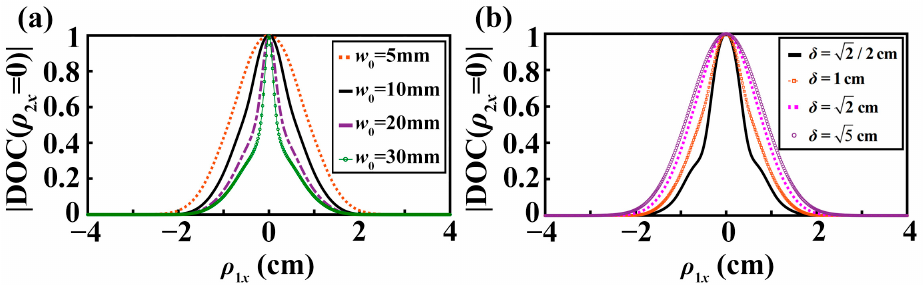
Figure 9. The cross ‐ line ( ρ 2 x = 0) of the absolute value of the spectral DOC of LNUC beams at z = 150 m for different ( a ) beam widths and ( b ) coherence lengths.